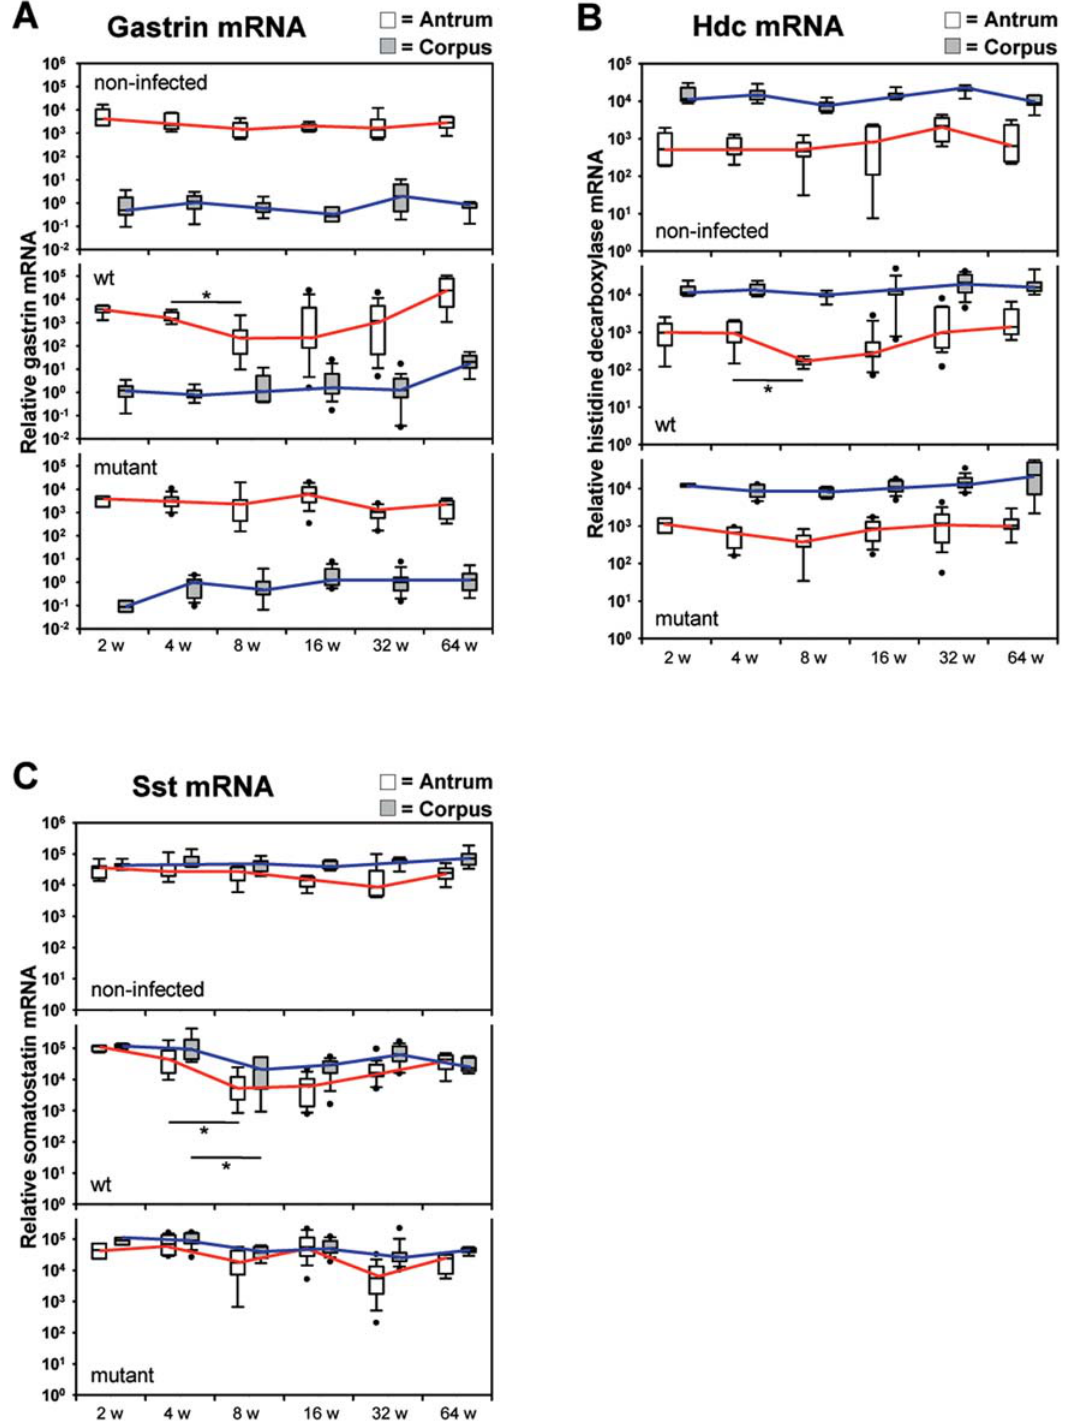
Figure 7. Decrease in gastrin-, histidine decarboxylase-, and somatostatin mRNA due to the H.pylori B128 WT-infection. (A) Gastrin-, (B) histidine decarboxylase-, and (C) somatostatin mRNA were measured by real-time RT-PCR normalized to 18S ribosomal RNA of antral (white box) and corpus (gray box) mucosa of gerbils orally challenged with H. pylori B128 WT (middle panels) and B128 D cag Y (bottom panels) isogenic mutant strain for 2, 4, 8, 16, 32, and 64 weeks compared with age-matched non-infected controls (upper panels). All box plots show 25th to 75th percentiles (box) and 5th to 95th percentiles (whiskers). The line in the box represents the median. Solid dots are outliers below 5% and above 95%. The interpolated lines connect the medians of the respective time-points. (*p , 0.05).